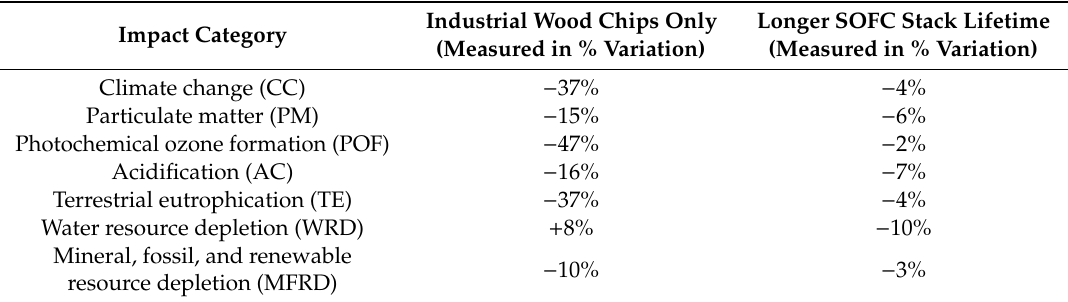
Table 5. Sensitivity analysis on the reduction of the environmental impact of the HBP technology by either increasing the SOFC stack lifetime or using only wood chips produced as industrial by-products. Industrial Wood Chips Only Longer SOFC Stack Lifetime Impact Category (Measured in % Variation) (Measured in % Variation) Climate change (CC) − 37% − 4% Particulate matter (PM) − 15% − 6% Photochemical ozone formation (POF) − 47% − 2% Acidification (AC) − 16% − 7% Terrestrial eutrophication (TE) − 37% − 4% Water resource depletion (WRD) + 8% − 10% Mineral, fossil, and renewable − 10% − resource depletion (MFRD)